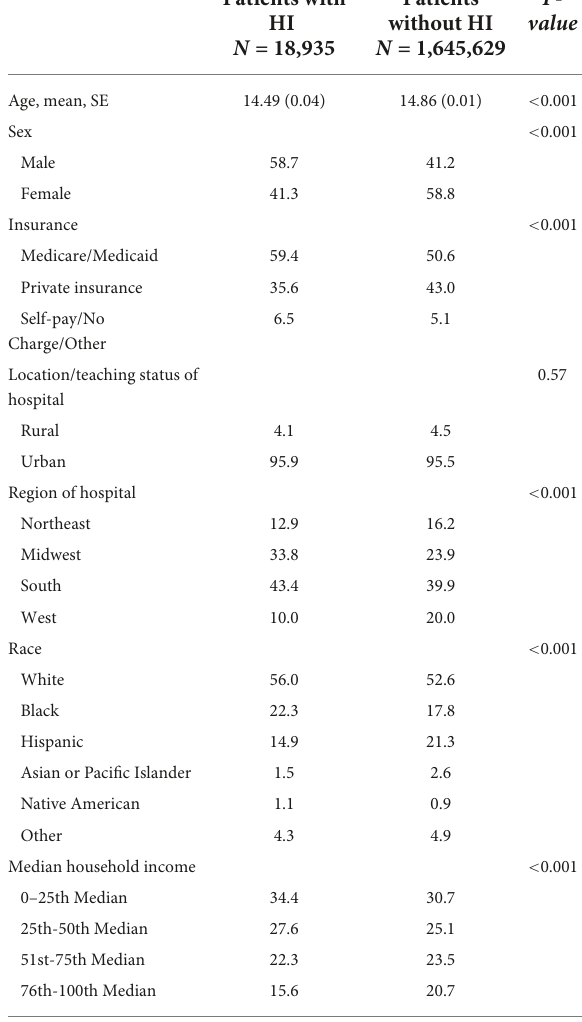
TABLE 1 Demographic characteristics of the patients (age 12–17) with and without homicidal